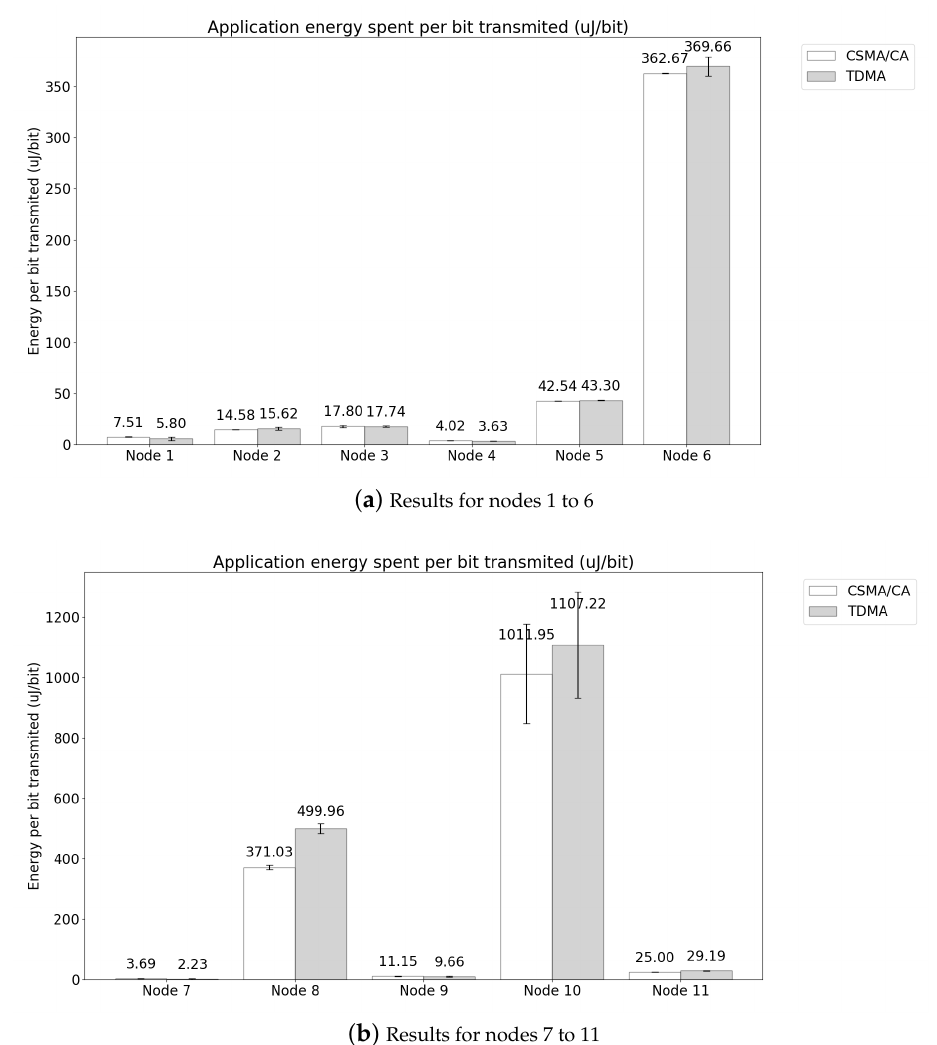
Figure 14. Energy spent per transmitted application bit in 12 nodes